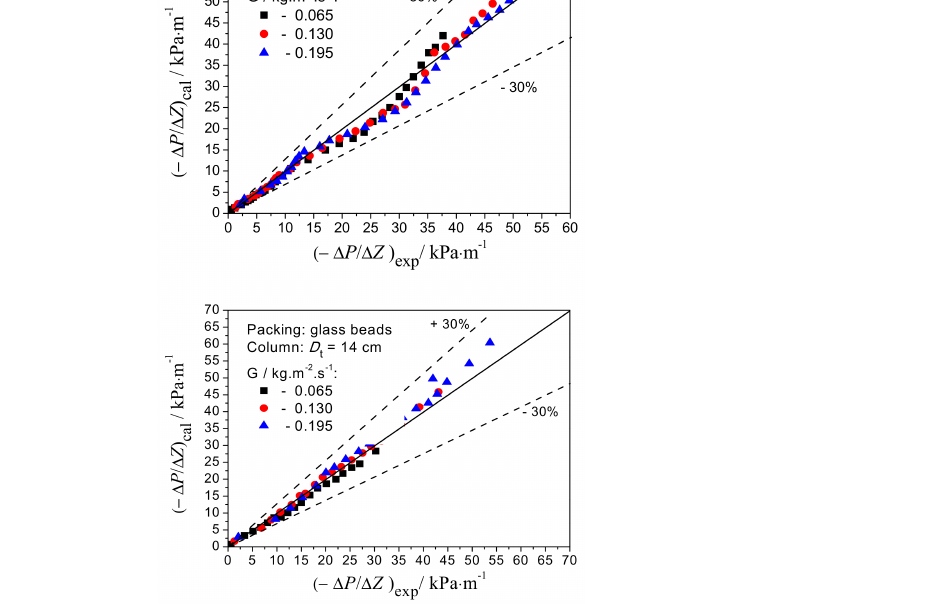
Figure 4. Parity plots of pressure drop measurements versus the predictions. The wetting condition over the packing surface can be represented by the liquid flow texture in the form of fractions of the stagnant liquid, film flow and rivulet flow, which are shown in Figures